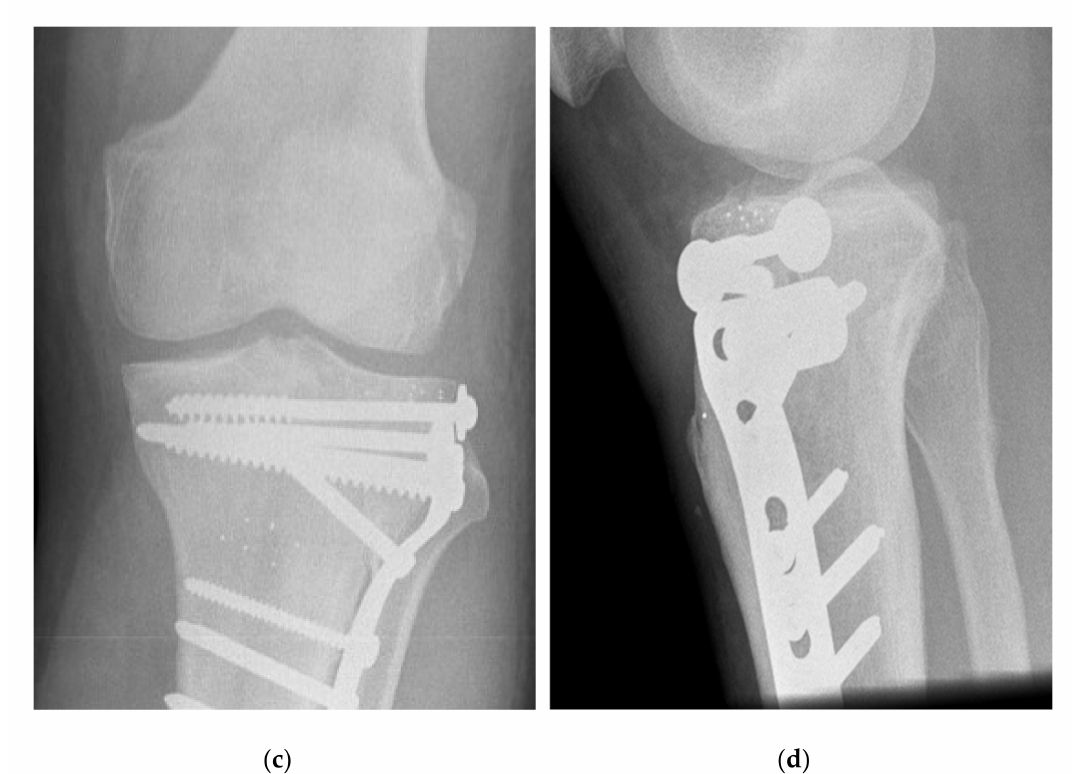
Figure 1. Preoperative AP ( a ) and lateral ( b ) with postoperative Day 2 AP ( c ) and lateral ( d ) radio- graphs of a reduced tibial plateau fracture (Schatzker II) in a patient without medical comorbidities.